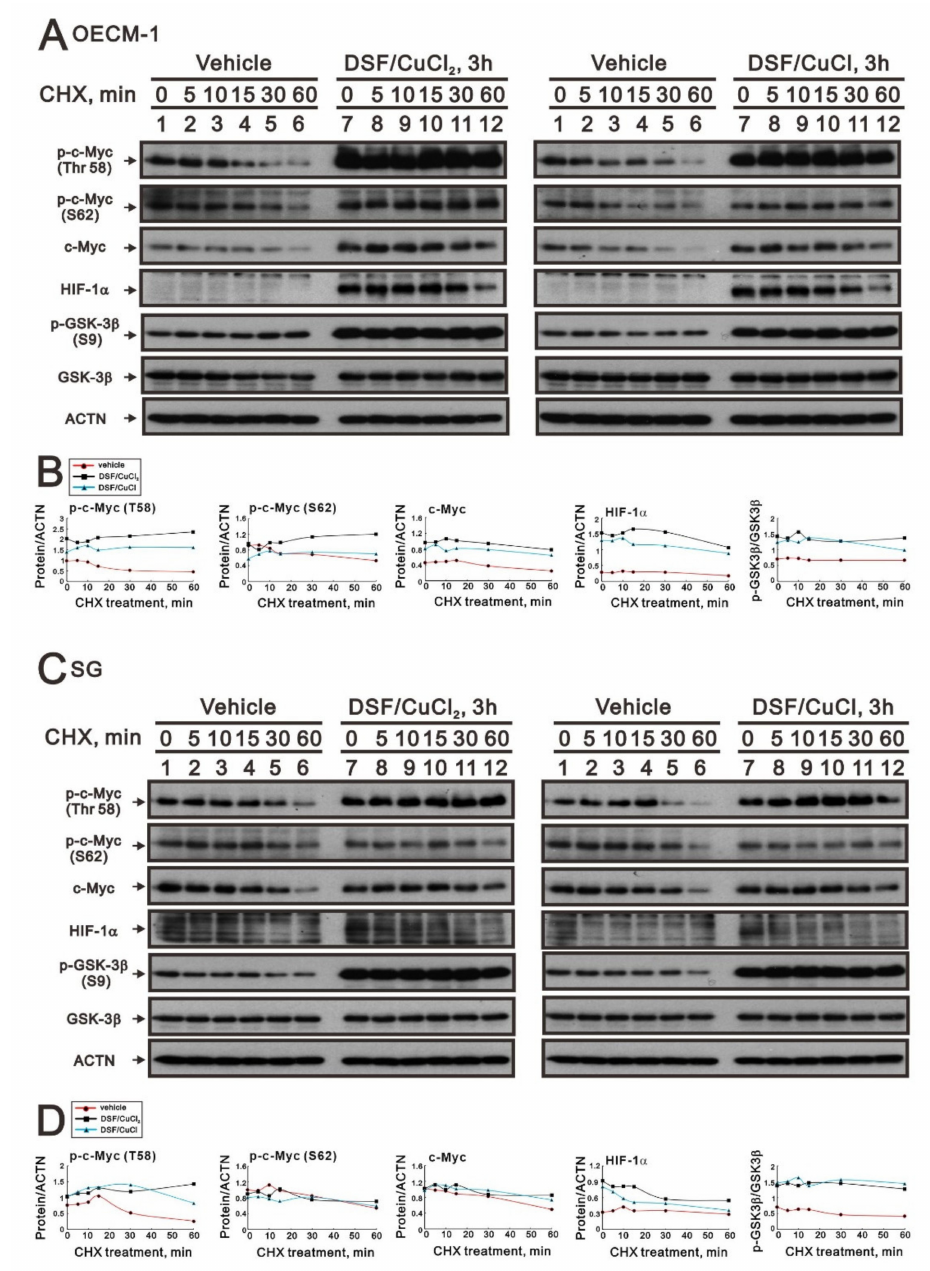
Figure 7. The effects of DSF, copper ions, and DSF/copper complexes on GSK3 β activity for the c-Myc and HIF-1 α proteins in OECM-1 and SG cells. ( A ) OECM-1 and ( C ) SG cells were treated with 50 µ M of CuCl 2 plus 0.5 µ M of DS or 2 µ M of CuCl plus 0.5 µ M of DSF for 3 h, accompanied by 50 mg/mL CHX for 0, 5, 10, 15, 30, and 60 min. The cell lysates were subjected to Western blot analysis using antibodies against the indicated proteins. ACTN was a loading protein control. The protein bands ( A , C ) were quantified through pixel density scanning and evaluated using ImageJ, version 1.44a (http://imagej.nih.gov/ij/) (accessed on 1 May 2022). The ratios of protein/ACTN and pGSK3 β /GSK3 β are plotted with red lines (vehicle), mint green lines (DSF/CuCl), and black lines (DSF/CuCl 2 ) in ( B ) OECM-1 and ( D ) SG